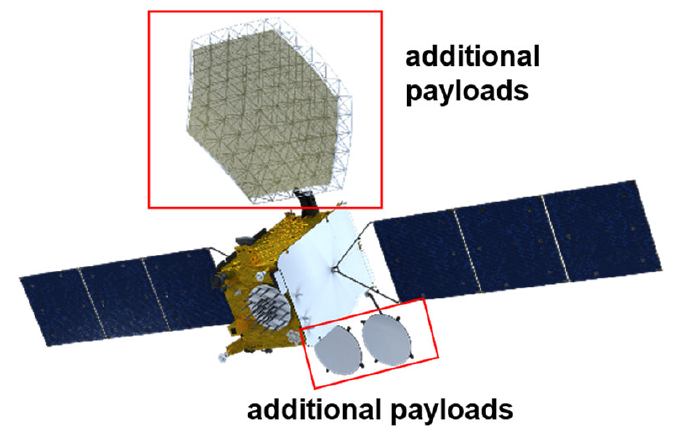
Figure 5. The structure of BDS-3 IGSO satellites (http://www.csno-tarc.cn/en/system/introduction (accessed on 7 November 2022)). Table 2. Final satellite-specific PCO z-offset, the unit is mm.